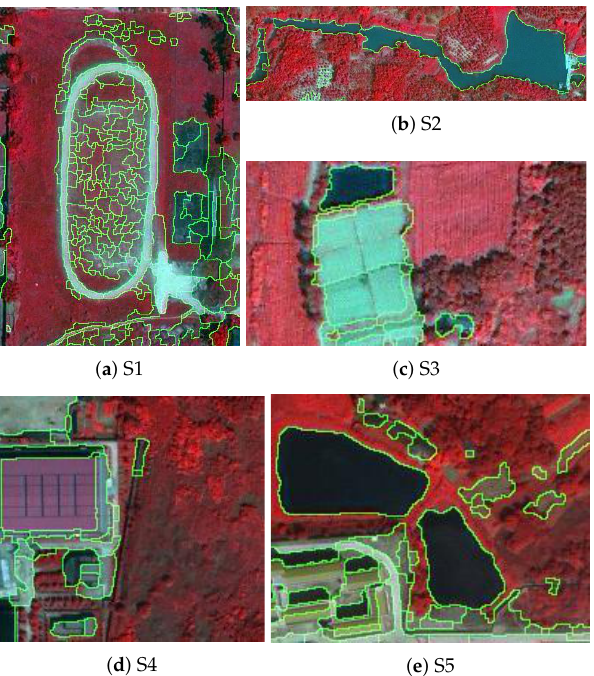
Figure 11. The optimal image segmentation by automatically selecting the threshold of spectral indices’